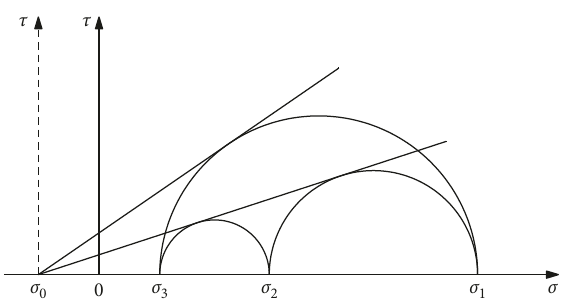
Figure 2: Limit stress state of generalized SMP criterion in the plane strain